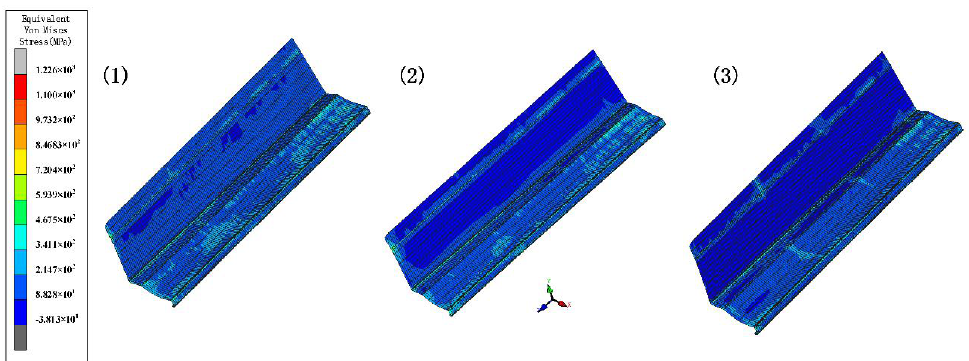
Materials 2022 , 15 , x FOR PEER REVIEW Figure 18. ( a ) Displacement X of strip in 3 diameter increments; ( b ) cross – section of 3 diameter in- Figure 18. ( a ) Displacement X of strip in 3 diameter increments; ( b ) cross-section of 3 diameter increments. crements.